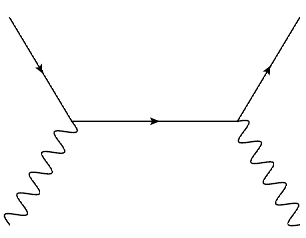
Figure 1 . Feynman diagram with an exchange of the massive spin- 5 / 2